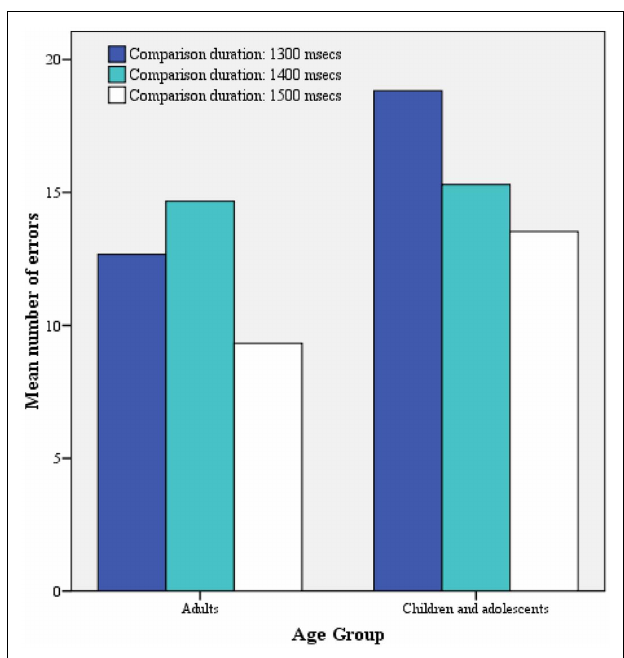
FIGURE 1 | Mean number of time discrimination errors for each comparison duration for each age